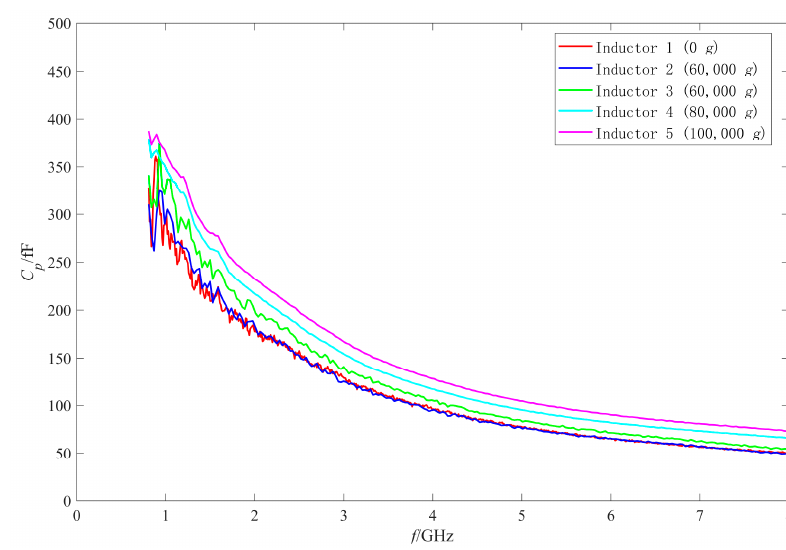
Figure 26. 𝐶 (cid:3043) of the failed inductors after shock test.